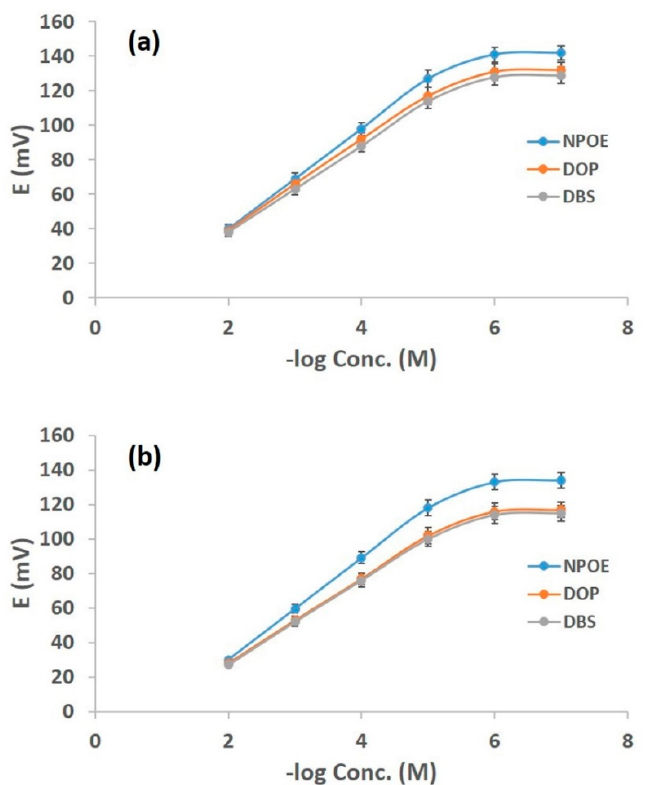
Figure 3. Profile of the potential (in mV) versus –log concentration (in M) for ( a ) PVC membrane electrode and ( b ) GC electrode at pH 9, using different solvent mediators.